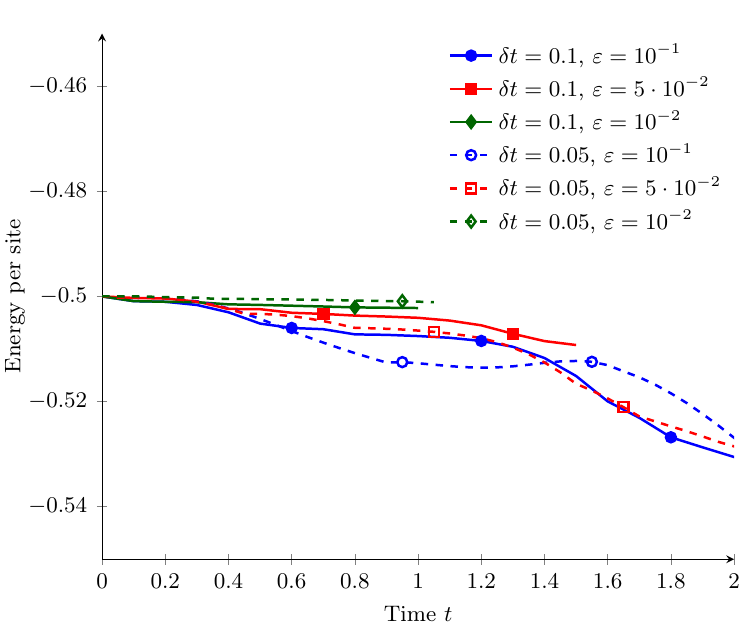
Figure 1: Energy per site over time at h = 4 as obtained from some stable example configurations for δ t and (cid:34) . For the later plots Figs. 3 and 4, we have selected δ t = 0.1, (cid:34) = 0.05 (solid red squares) to represent h = 4 as the error is sufficiently small.